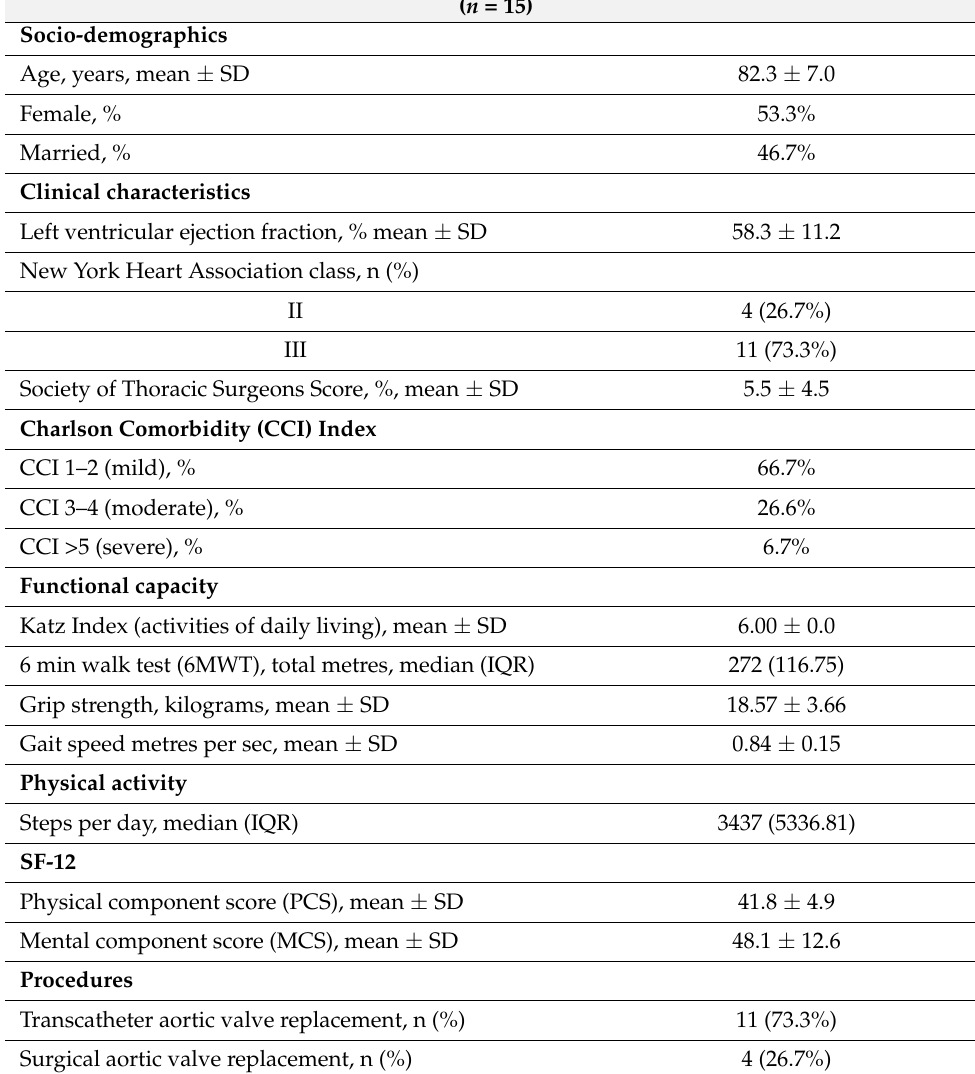
Table 1. Baseline participant demographic and clinical